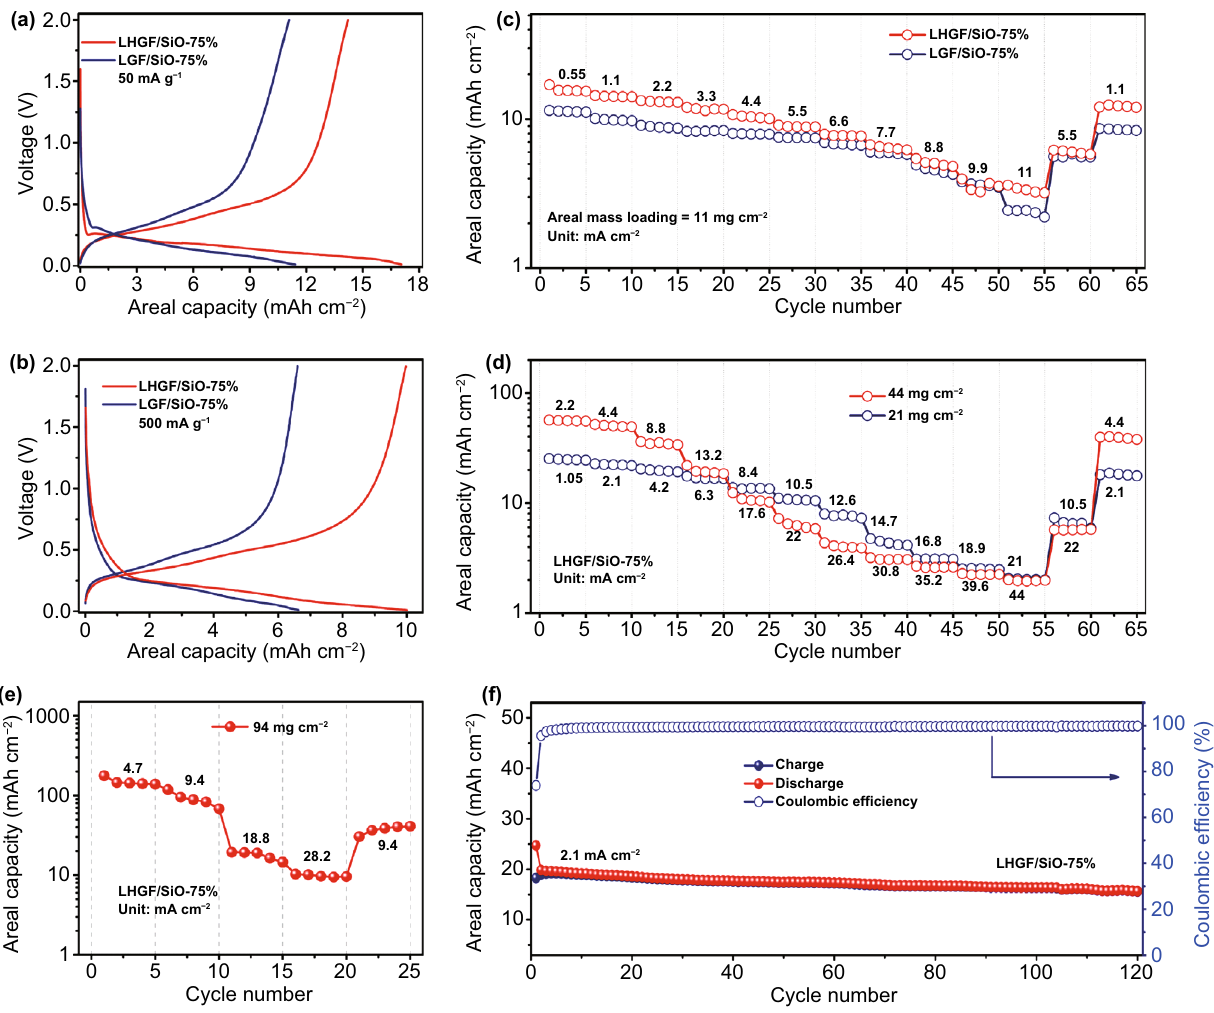
Fig. 3 Effects of mass loading on electrochemical characteristics. Galvanostatic charge/discharge curves of two type electrodes at a 50 mA g −1 and b 500 mA g −1 . The mass loading is 11 mg cm −2 . c Rate performances of LHGF/SiO-75% and LGF/SiO-75% electrode at the same mass loading of 11 mg cm −2 . d Rate performance of LHGF/SiO-75% electrode at the mass loadings of 21 and 44 mg cm −2 . e Rate performance of LHGF/SiO-75% electrode at the mass loading of 94 mg cm −2 . f Cycling performance of LHGF/SiO electrode with the mass loading of 21 mg cm −2 at a current density of 2.1 mA cm